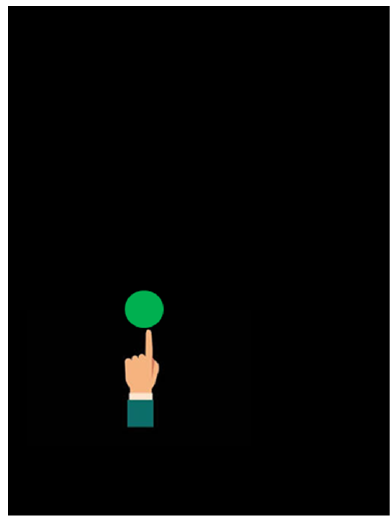
Figure 4. Touch exercise.